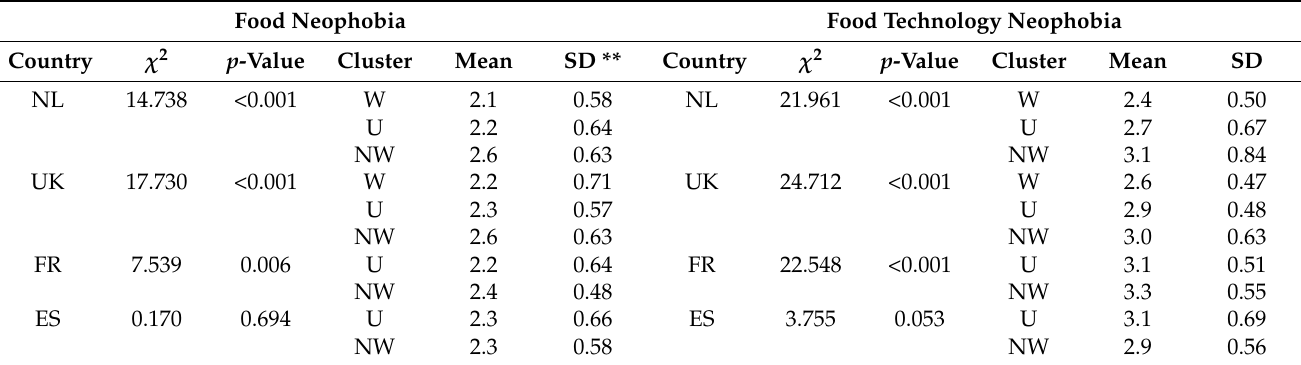
Table 4. Comparative Kruskal–Wallis * results for FNS and FTNS ( α = 0.05). p -values are significant for p <